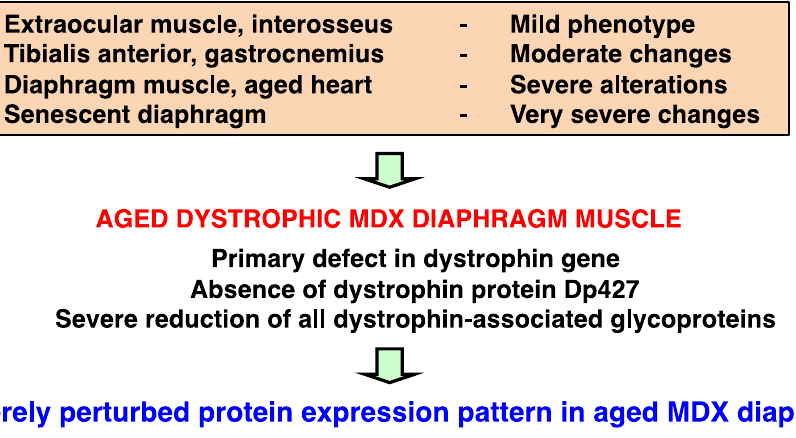
Figure 9. Proteomic profile of the aged mdx diaphragm muscle: The diagram summarizes the main classes of diaphragm proteins identified by the proteomic profiling of the aged and dystrophin-deficient mdx mouse model of X-linked muscular dystrophy. The severely perturbed protein expression pattern of dystrophic muscle tissue includes extracellular matrix proteins, contractile proteins, structural proteins, molecular chaperones, mitochondrial enzymes, glycolytic enzymes, calcium-binding proteins and metabolite transporters. Thus, the deficiency in dystrophin isoform Dp427 and concomitant reduction in dystrophin-associated glycoproteins in the dystrophic sarcolemma appears to trigger a large range of secondary abnormalities in muscular